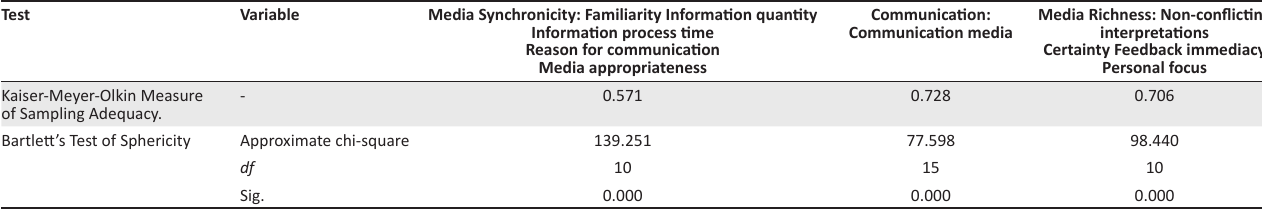
TABLE 3: Kaiser–Mayer–Olkin and Bartlett’s test. Test